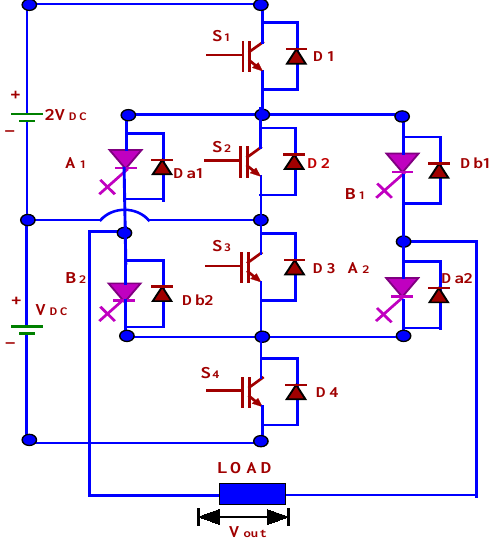
Figure 1. Single phase asymmetric seven-level inverter.